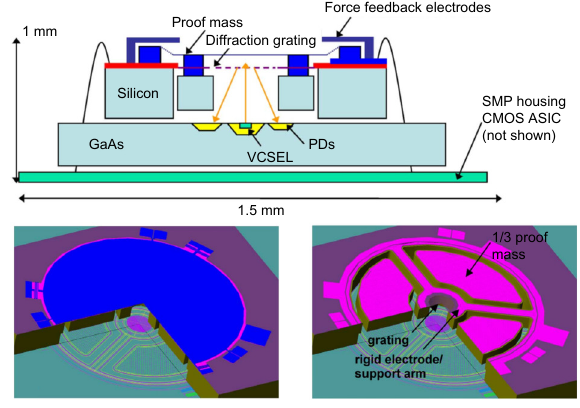
Fig. 9 | Schematic of the grating interferometric cavity based ac- celerometer. Figure reproduced from ref. 31 , IEEE